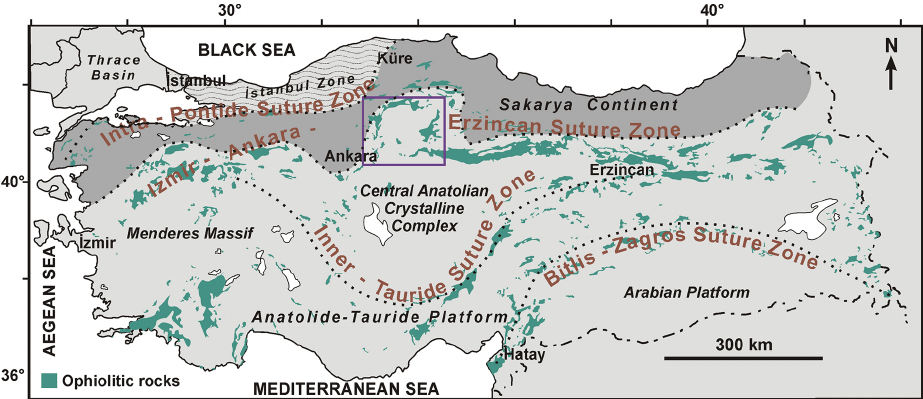
Fig. 1. Simplified ophiolite map of Turkey showing the distribution of the suture zones and some of the major tectonic entities in Turkey (from MTA, 2001). Pontide tectonic belt including the Sakarya Continent. The inset box refers to the map area in Fig.